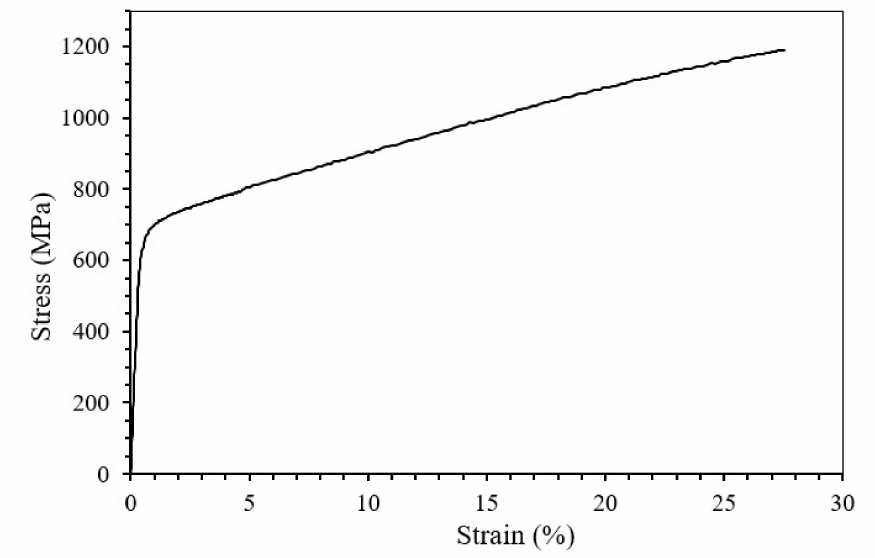
Figure 40. True stress–strain curve.